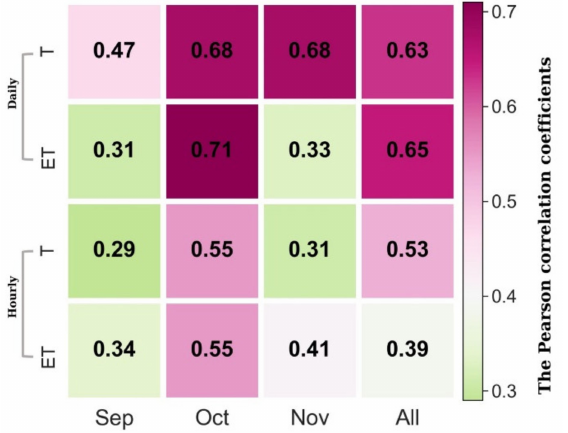
Figure 2. Hourly averages of far-red SIF, ET, GPP, T, PAR, VPD, air temperature, soil water and soil temperature ( A – I ) in September (blue), October (purple) and November (black). Shaded regions represent SE of the hourly mean.